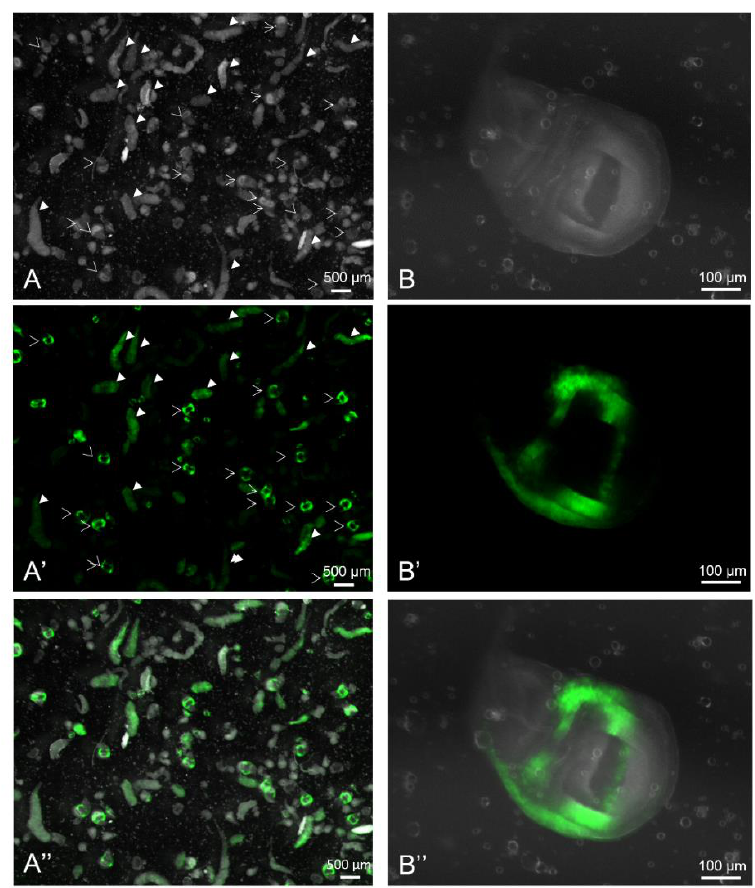
Figure 6. Yield and purity of the mass enrichment protocol. Overview of the resulting material obtained at the end of the procedure under white light ( A , B ) or GFP-exciting light ( A’ , B’ ). ( B – B” ) show wing imaginal discs (the posterior compartment is on the bottom) corresponding to a 6.4 times magnification of ( A – A ’’ ). Empty arrowheads point to wing imaginal discs, and filled arrowheads point to salivary glands. Procedure (protocol E) was performed on larvae expressing GFP under the control of the vestigial driver.